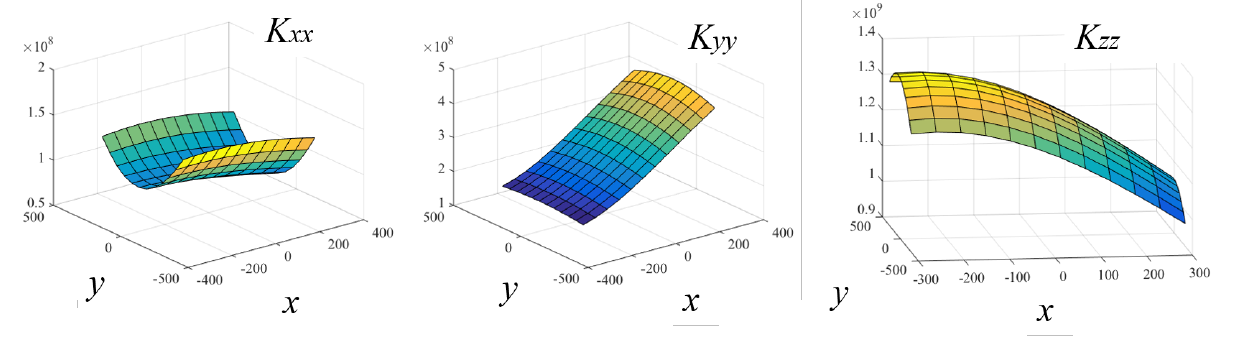
Figure 10. Principal stiffness coefficients of the Tripteor X7 along X, Y and Z axes in the XY − plane, z = 1.18